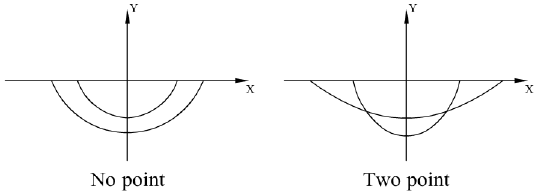
Figure 5. Prediction of curves occurring at different grid densities.